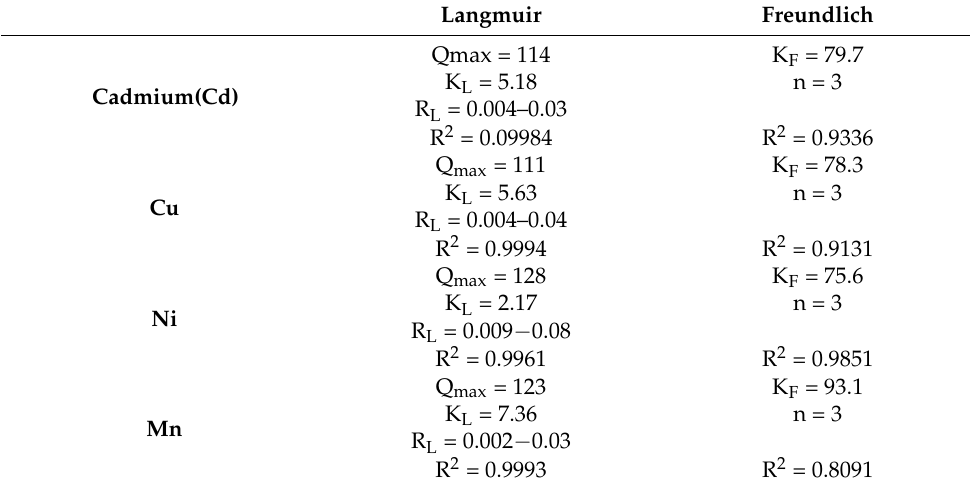
Table 2. Langmuir and Freundlich adsorption isotherm parameters.